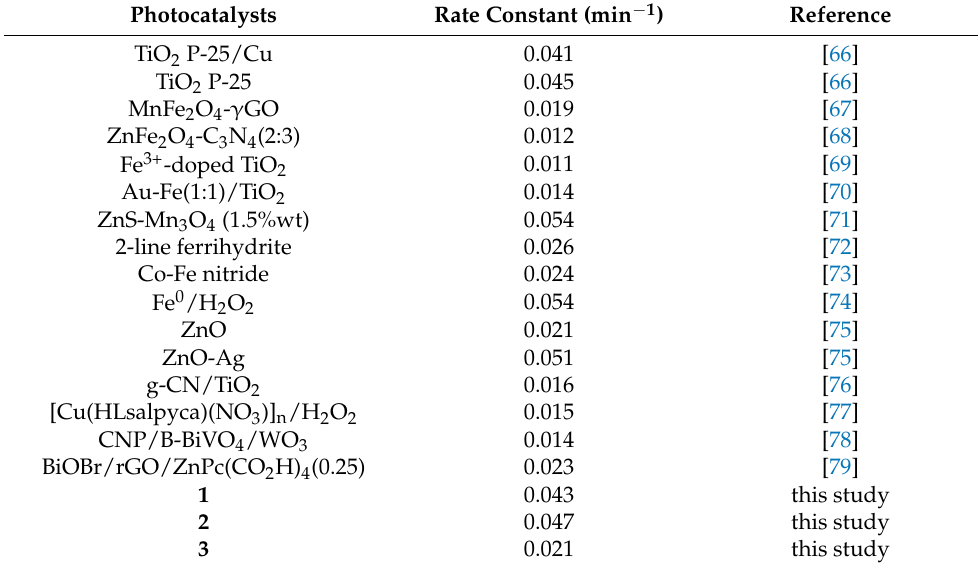
Table 1. A comparison of the photodegradation efficiency of AO with various